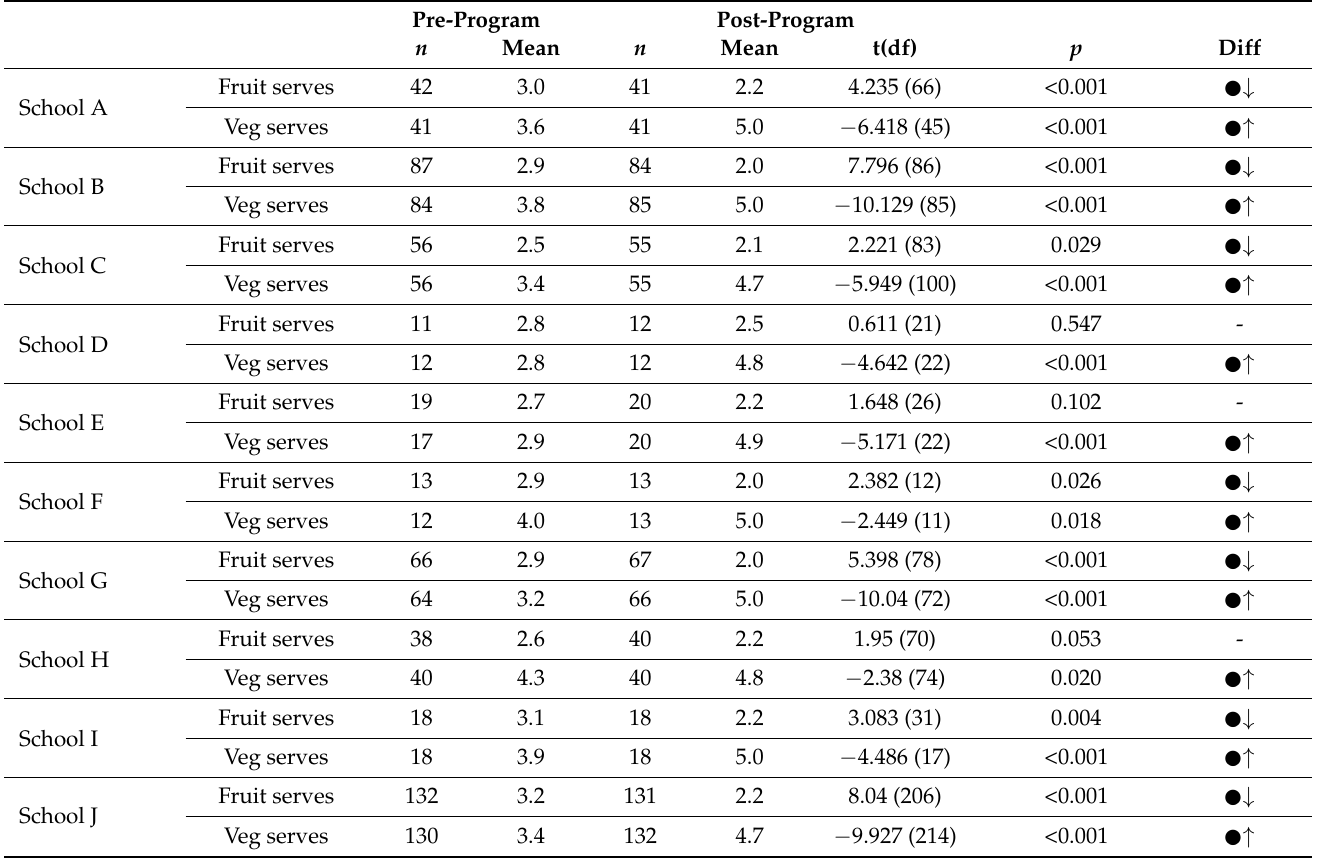
Table 3. Independent Samples t-Test results—Nutrition